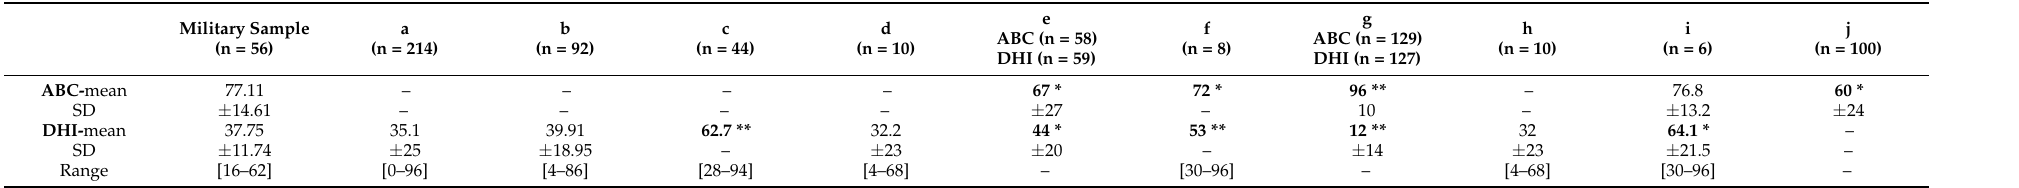
Table 2. Comparison of the self-reported vestibular symptom burden following a